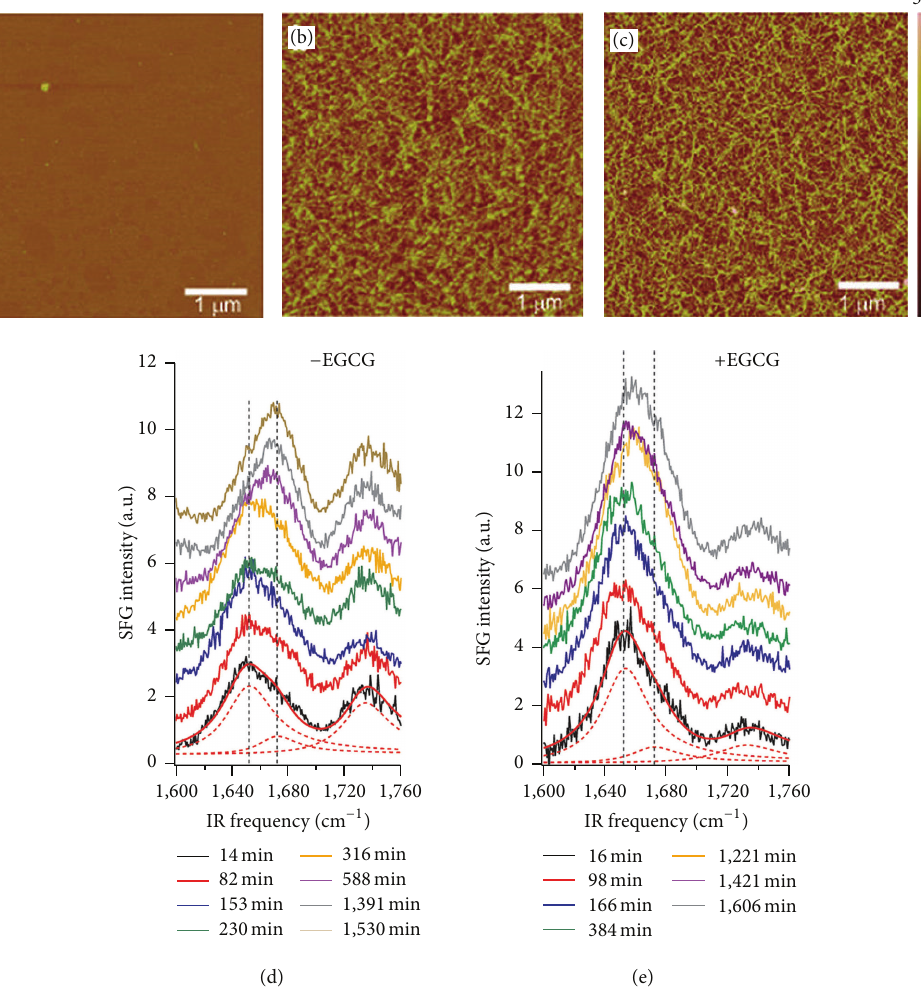
Figure 5: Kinetics study using AFM and SFG measurements during hIAPP aggregation at the phospholipid interface in the presence, or absence, of EGCG. AFM images of hIAPP with lipid for (a) 10 and (b) 1020 min in the absence of EGCG and (c) AFM image after hIAPP aggregation in the presence of EGCG for 1020 min. SFG spectra of hIAPP with phospholipid in the amid I region (d) in the absence of, and (e) in the presence of, EGCG. Adapted from [64] with permission. Copyright 2012 American Chemical